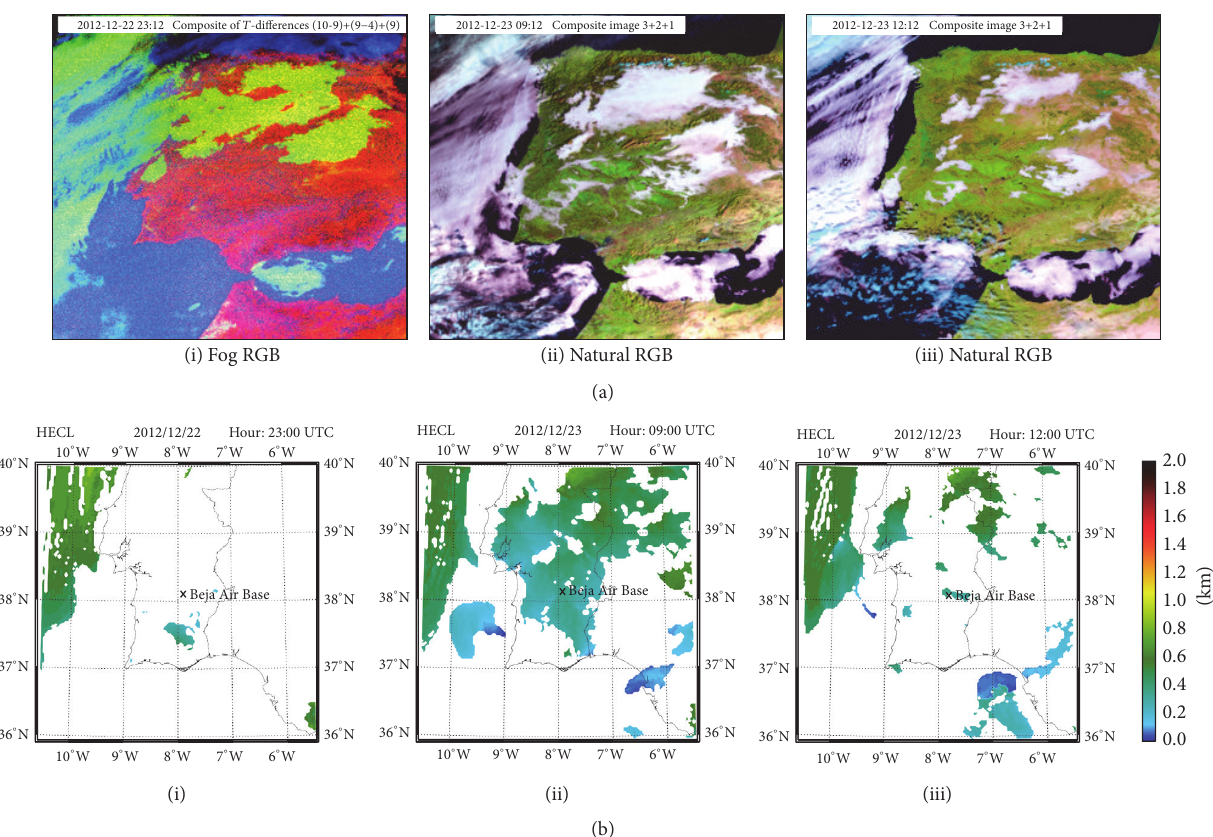
Figure 8: (a) Sequence of satellite images in 22/12/2012 at 23:12 UTC and in 23/12/2012 at 09:12 and 12:12 UTC of 23/12/2012; (b) simulation of explicit cloud top height from the surface in 22/12/2012 at 23:00 and in 23/12/2012 at 09:00 and 12:00 UTC in D1 domain.